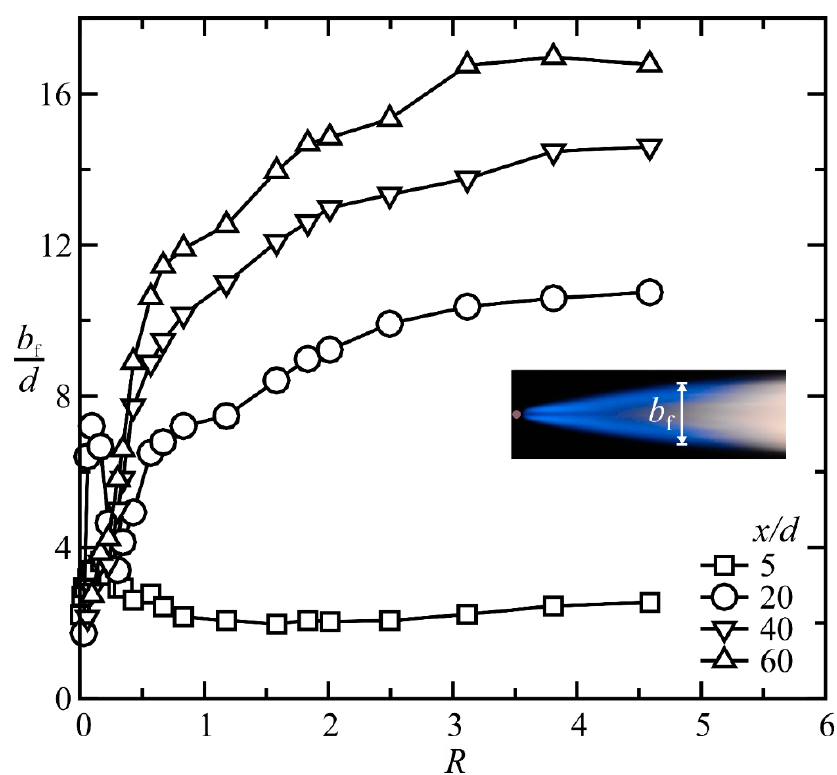
Figure 4. Variation of flame span width. θ = 15°.